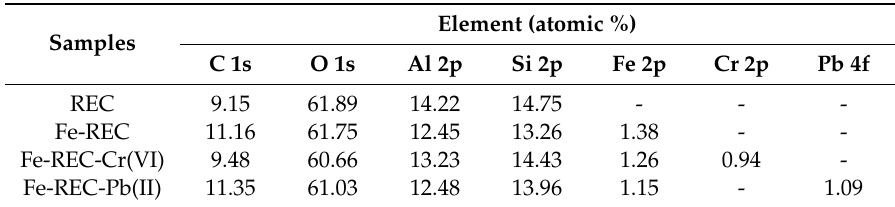
Table 2. The change of atomic relative concentration on the REC surface after its modification and